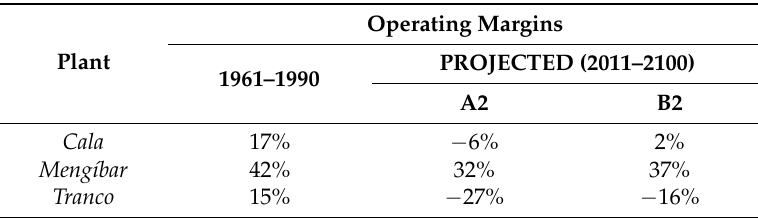
Table 7. Evolution of operating margins at pilot centers.